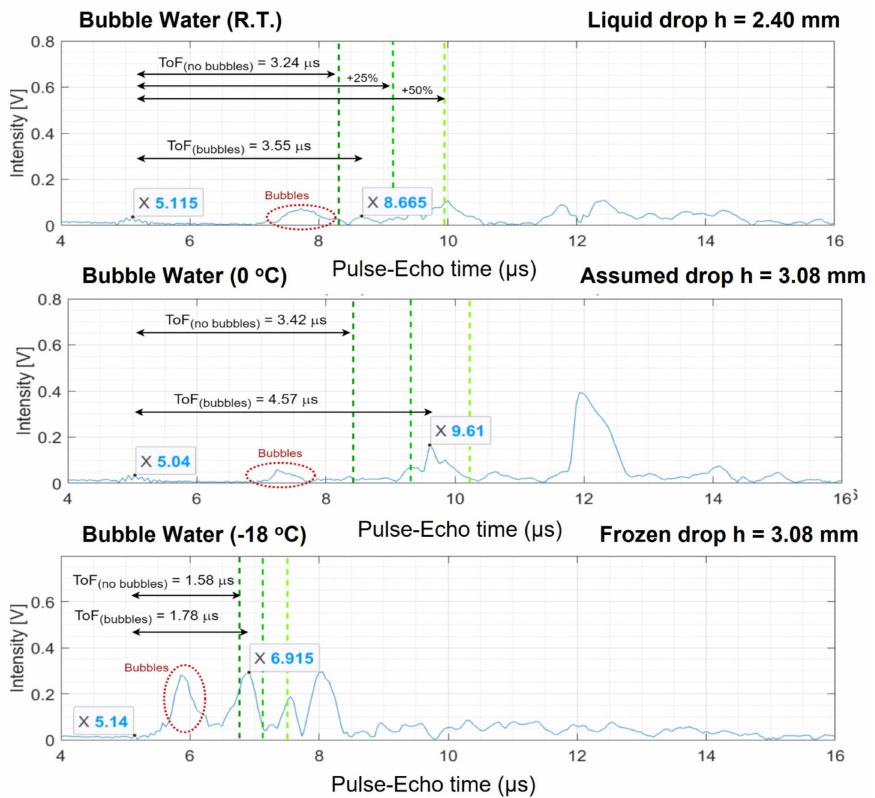
Figure 7. Typical set of A-scans for Drop Experiment 1. For three different temperature values, the ToF of the hypothetical compact ice (without bubbles) is drawn as the dark green dotted line. The other green dotted lines indicate lines of 25% and 50% beyond this ToF. The ToF of the top of the porous drop is labelled as ToF (bubbles) . The peaks that likely indicate bubbles are shown in the red dotted